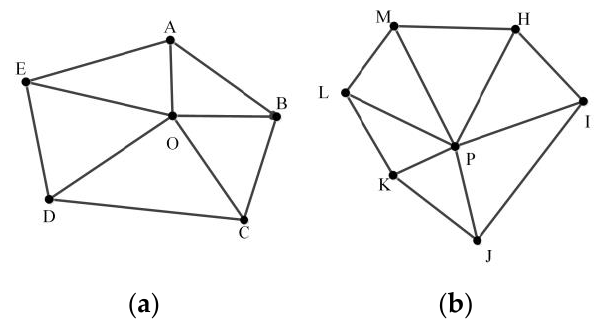
Figure 10. MMU with rotation offset. ( a ) MMU O and ( b ) MMU P .